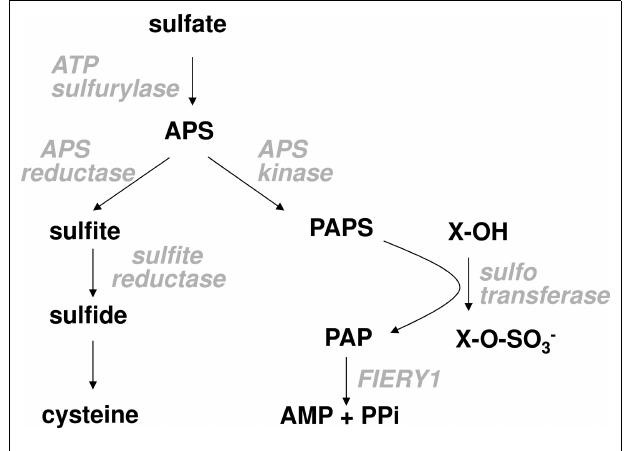
FIGURE 1 | Scheme of plant sulfate